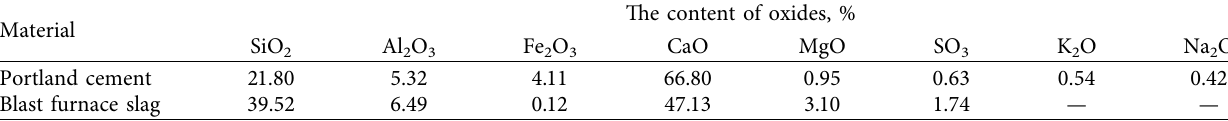
Table 2: Chemical composition of raw